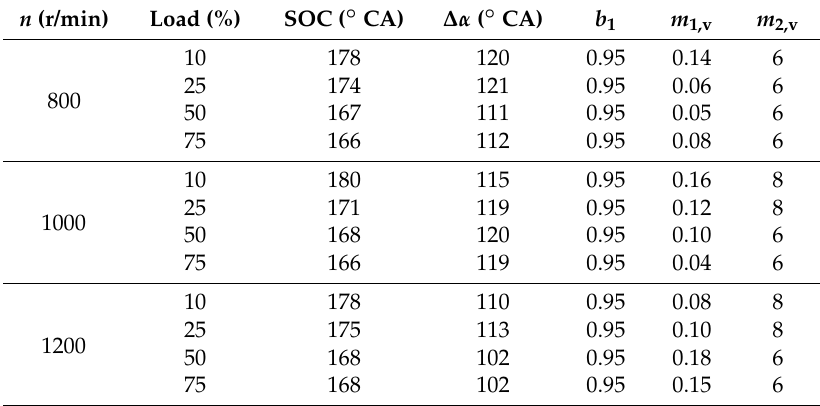
Table 4. Vibe parameters under different working conditions